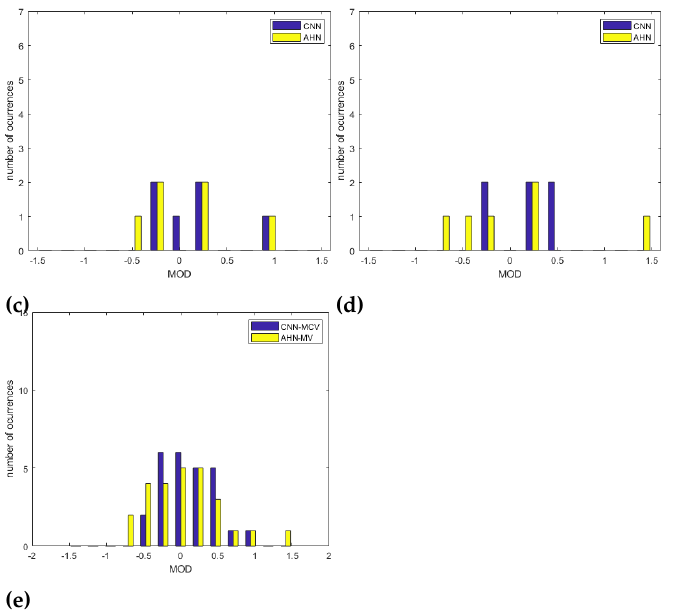
Figure 12. Overlapped histograms of MOD for AHN-MV and CNN-MCV strategies for ( a ) ‘LD’ position, ( b ) ‘S’ position, ( c ) ‘LF’ position and ( d ) ‘LU’ position. In ( e ) Overlapped histograms of MOD for AHN-MV and CNN-MCV strategies for all the